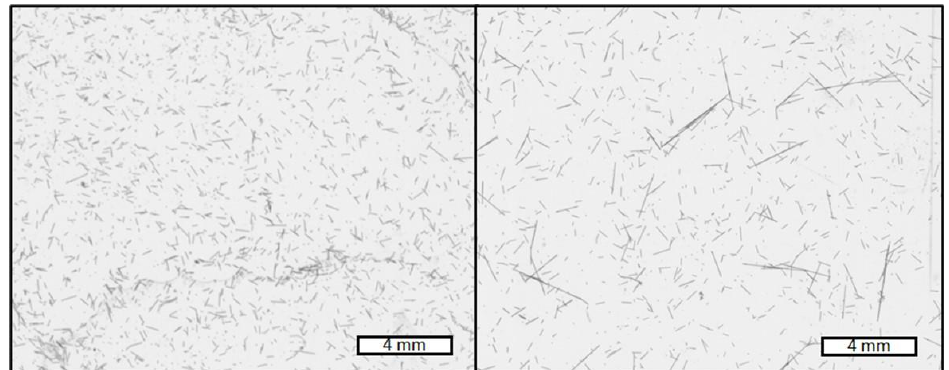
Figure 1. Example of images generated by scanning the Petri dish with the fibers dispersed in water for evaluating the fiber length using the Fasep-software. Fibers from samples with 15 wt% of carbon fibers, dosed into zone 3 ( left ) and zone 8 ( right ). The scale bar represents 4 mm length. The reader can see a qualitative difference in how the fibers are broken down: in the right picture with a shorter processing length, several longer fibers can be seen in comparison with only shorter fibers in the left picture, where the longer processing length was applied to the compound.